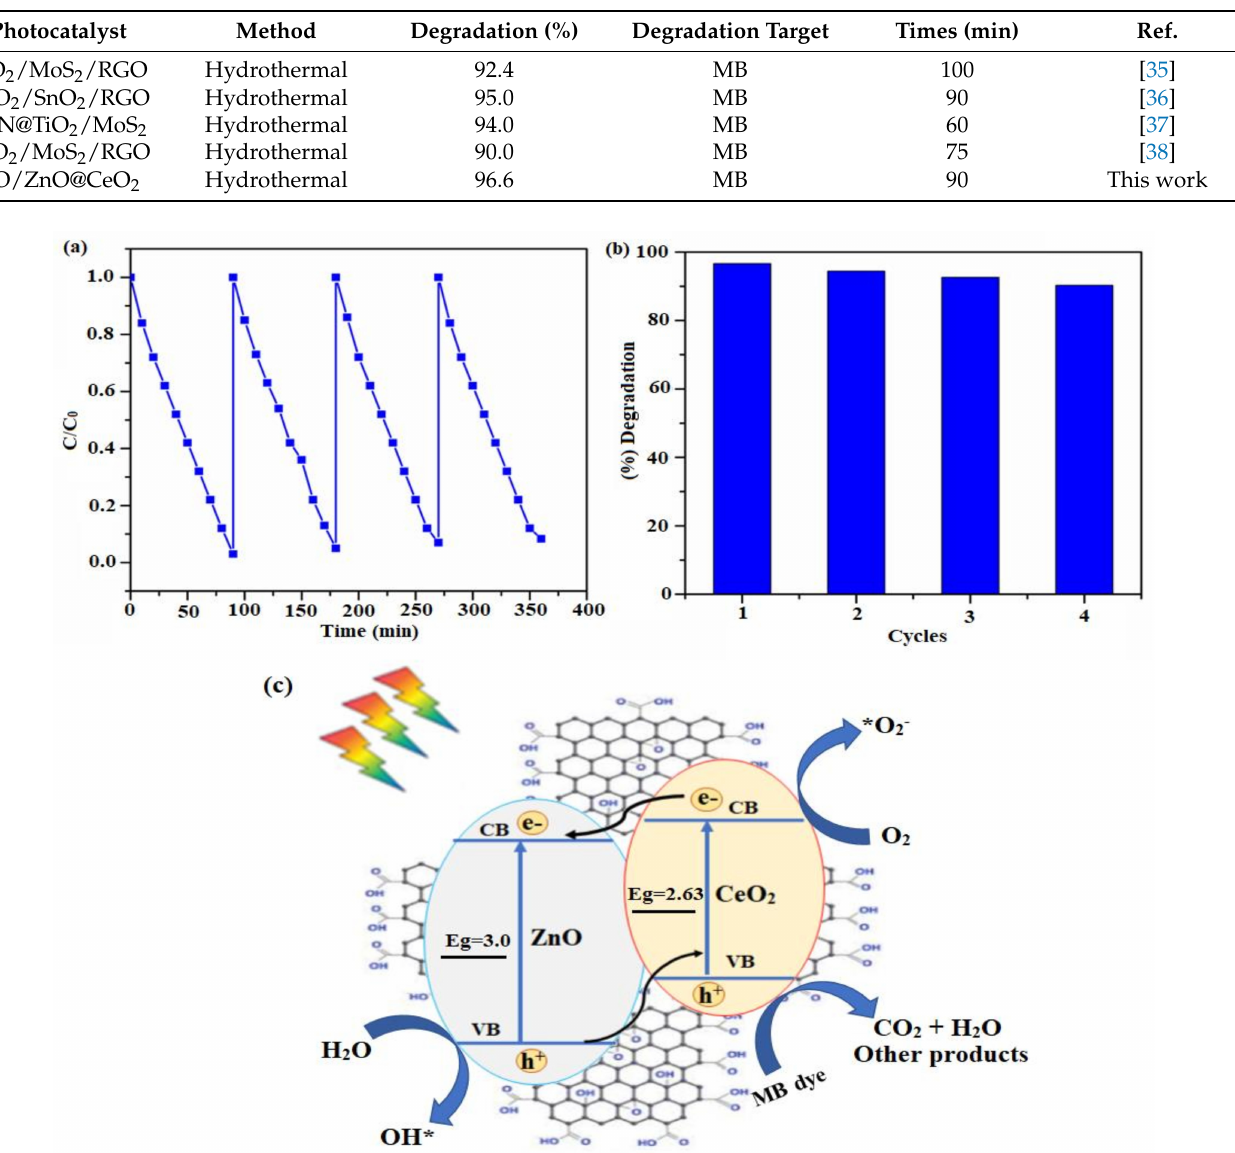
Figure 7. ( a ) Stability, ( b ) recyclability and ( c ) photocatalytic mechanism using GO-ZnO@CeO 2